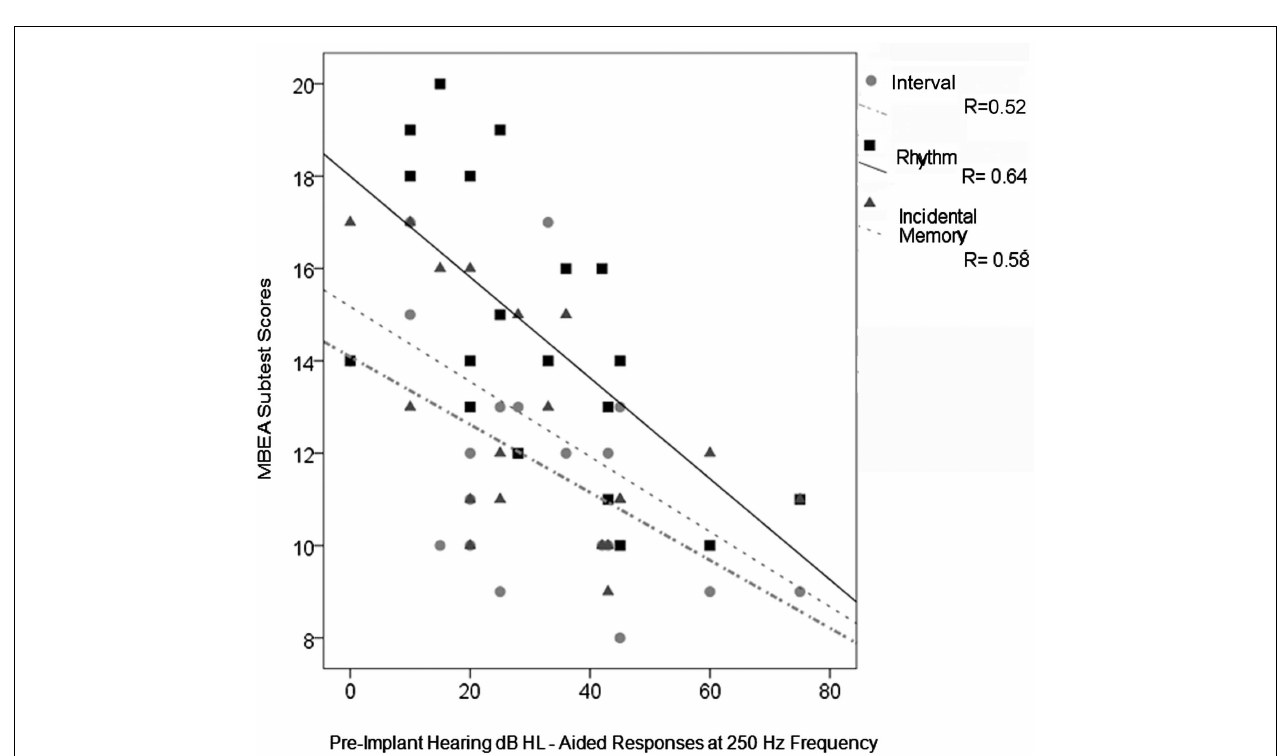
FIGURE 5 | MBEA total scores and test scores for Interval, Rhythm, and Incidental Memory significantly decreased with decreasing residual hearing (measured by higher aided thresholds at 250Hz prior to cochlear